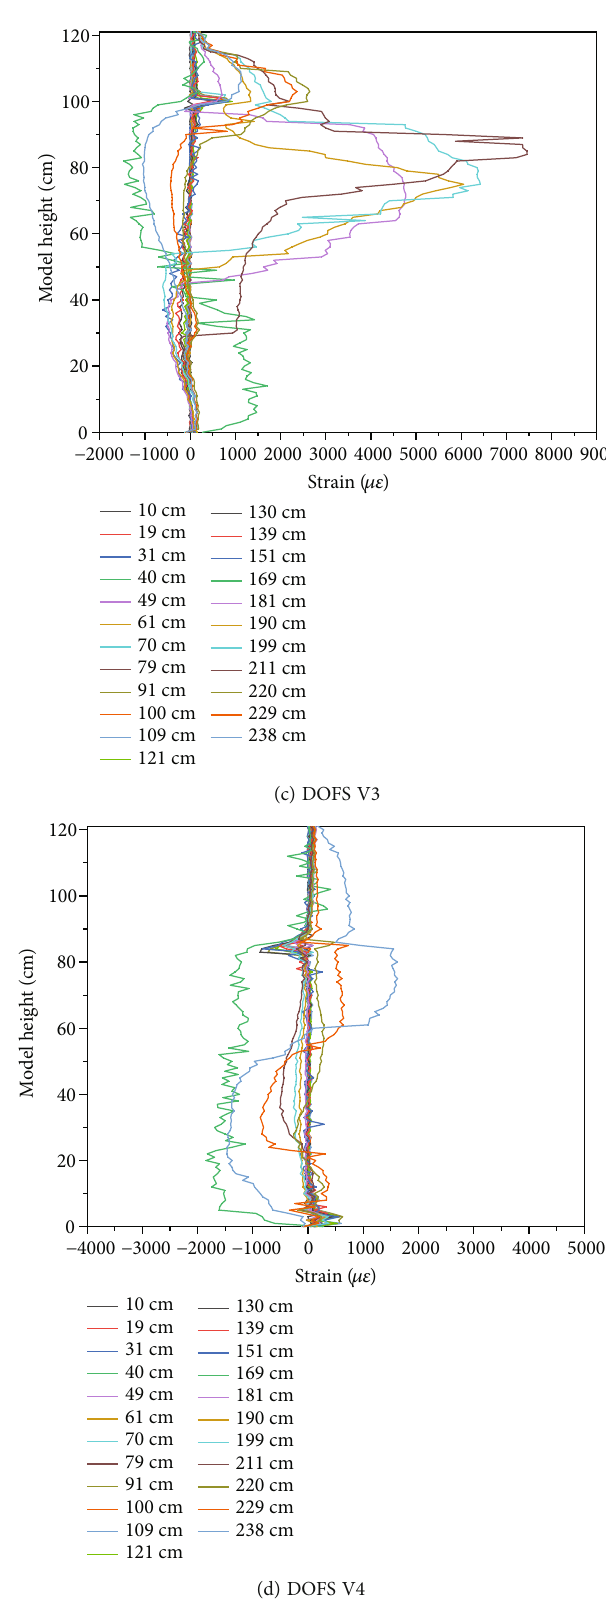
Figure 3: Strain monitoring results of DOFS V1-V4 in the mining of coal seam 1 -2